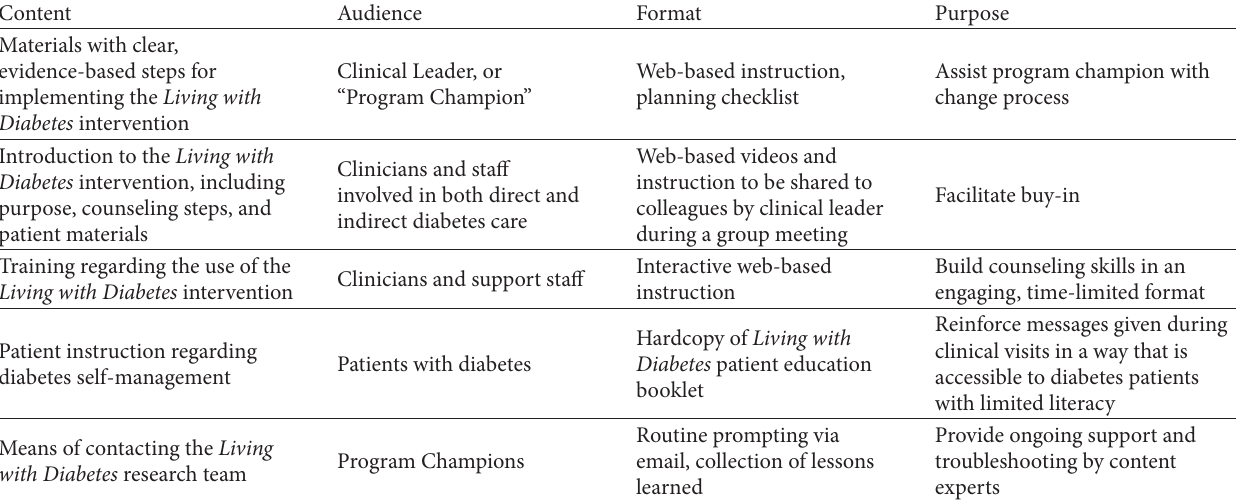
Table 2: Elements of implementation